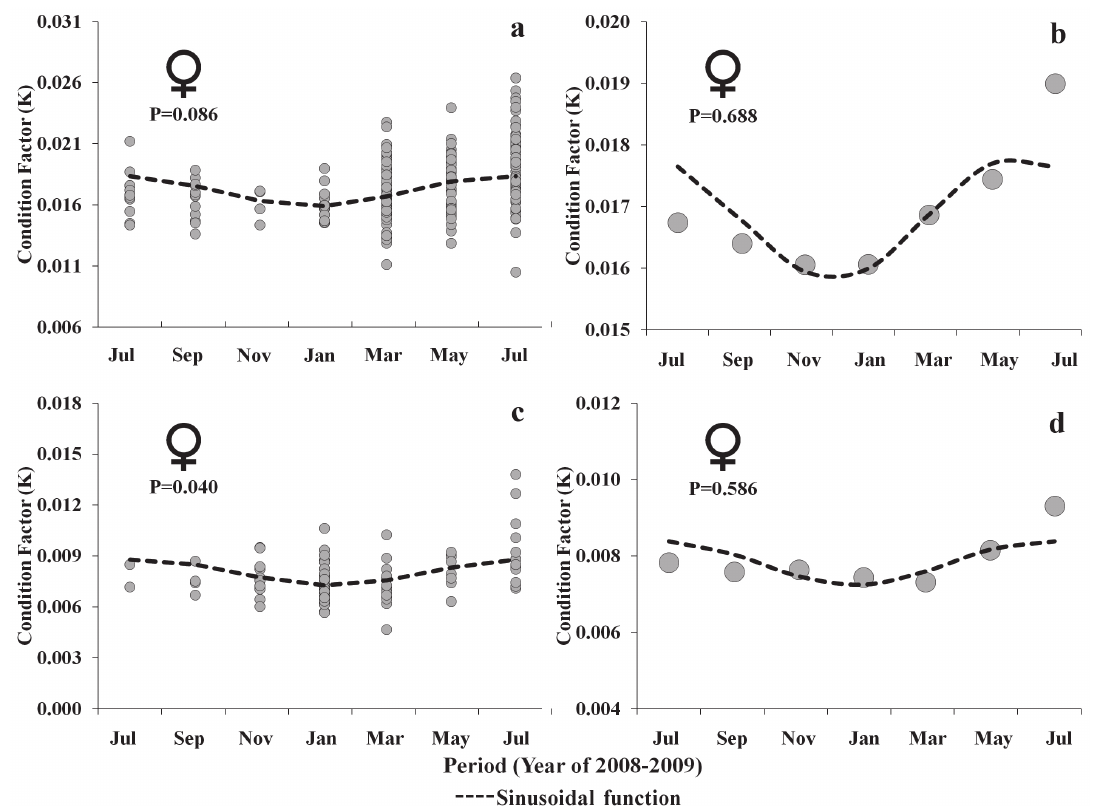
Fig. 6. Bimonthly variation in the raw data ( a , c ) and mean values ( b , d ) for the condition factor (K) in juvenile ( a , b ) and adult ( c , d ) female of the Auchenipterichthys longimanus collected from July 2008 to July 2009 in the Caxiuanã National